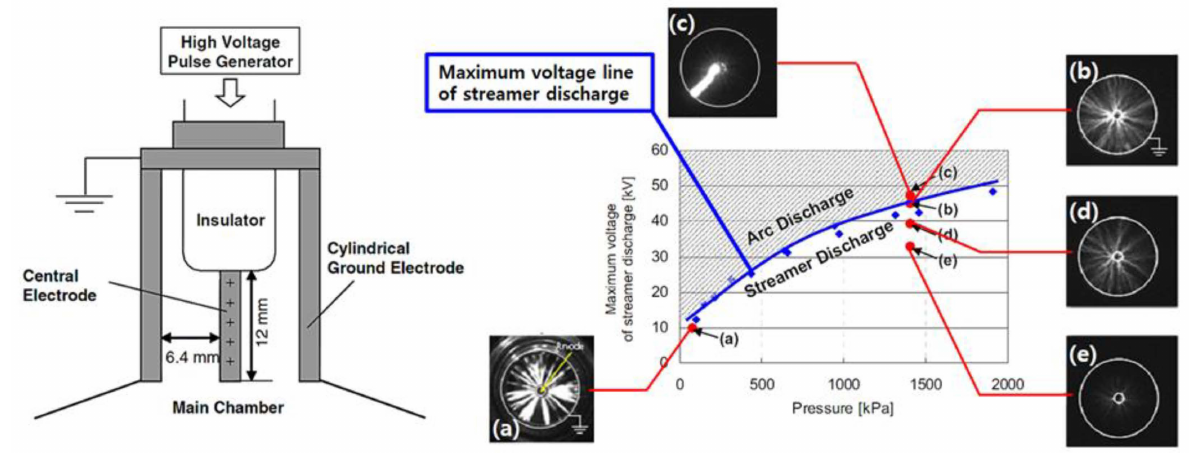
Figure 7. Schematic of a volumetric plasma igniter and ignition characteristics according to the applied voltage and ambient pressure